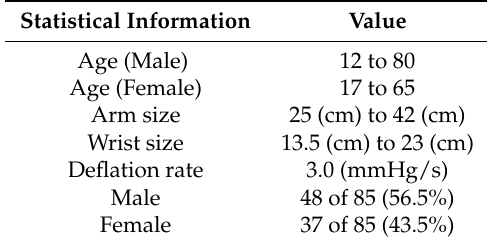
Table 1. The statistical information about eighty five